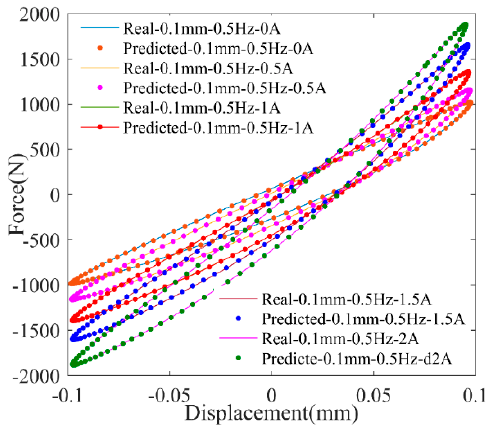
Figure 9. Force–displacement loops of MRE isolator under various applied currents for A = 0.10 mm at 0.5 Hz.